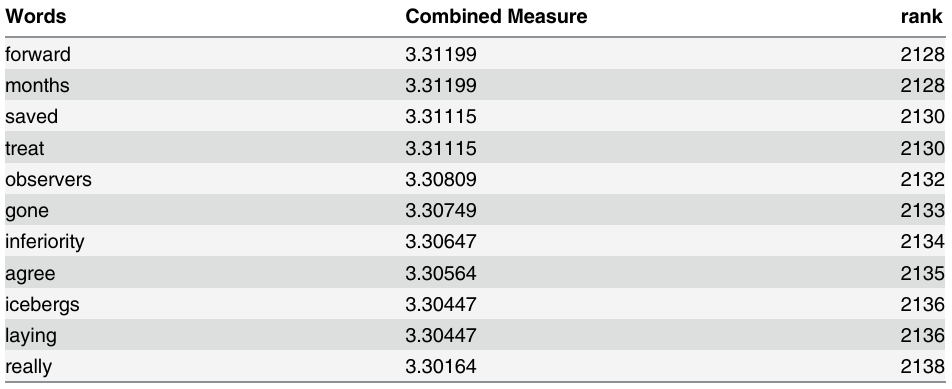
Table 3. List of ten words and their ranks from the book The Origin of Species . Words with equal Com- bined Measures take equal ranks. Words